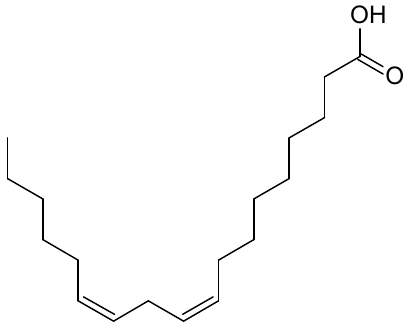
Figure 10. T structure of linoleic acid. Figure 10. The structure of linoleic